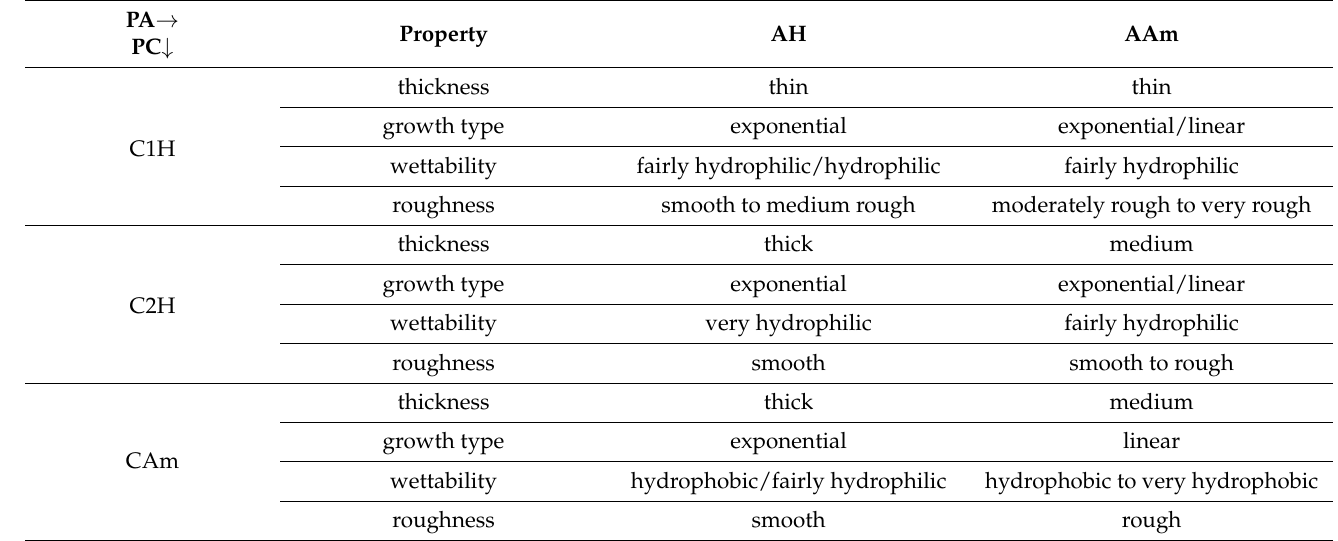
Table 5. Summary of the properties of the